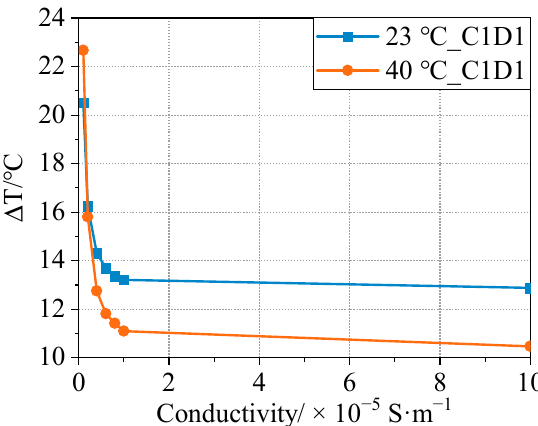
Figure 13. Simulation results of maximum surface temperature rise during the discharging process of the cell after aging when using different SEI ionic conductivities.